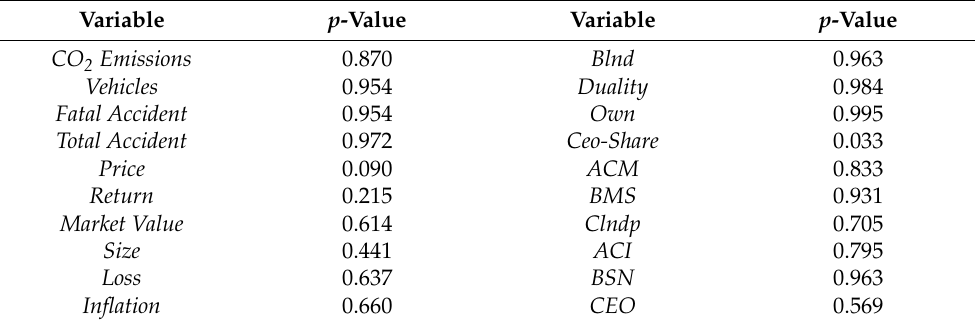
Table 3. The results of the normality test of the